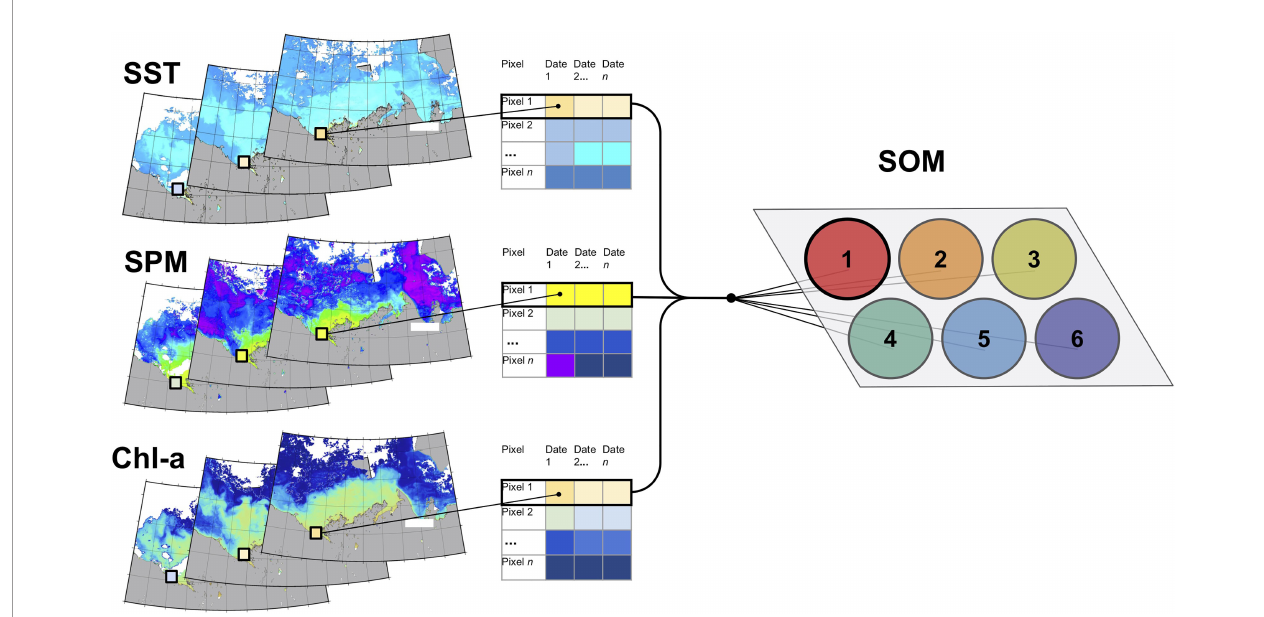
FIGURE 2 | Illustration of the SOM method clustering satellite-derived SST, SPM and Chl-a pixels. The input parameters were concatenated, and spatial pixels were individually presented to SOM nodes, which includes all values of that pixel over time for the three parameters. Each pixel is examined for similarity with the other pixels assigned to that node. This recurs over a set number of iterations with the fi nal characteristics of the node consisting of a weighted average of the assigned pixels and variables over time. Here the example pixel is assigned to Node